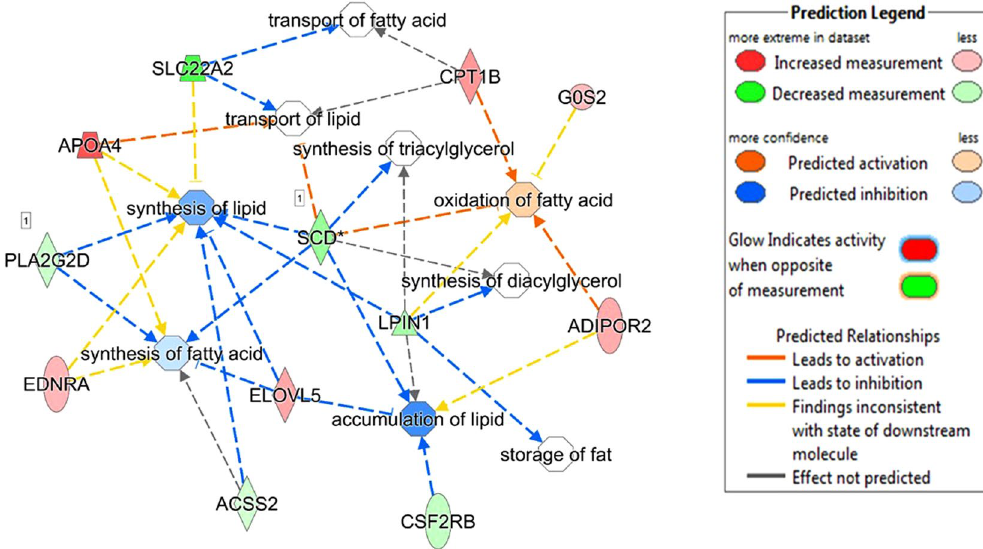
Figure 3. Metabolic process regulatory gene network showing differentially expressed (DE) genes involved in the different lipid metabolic processes and their predicted activation or deactivation levels in Angus low-RFI